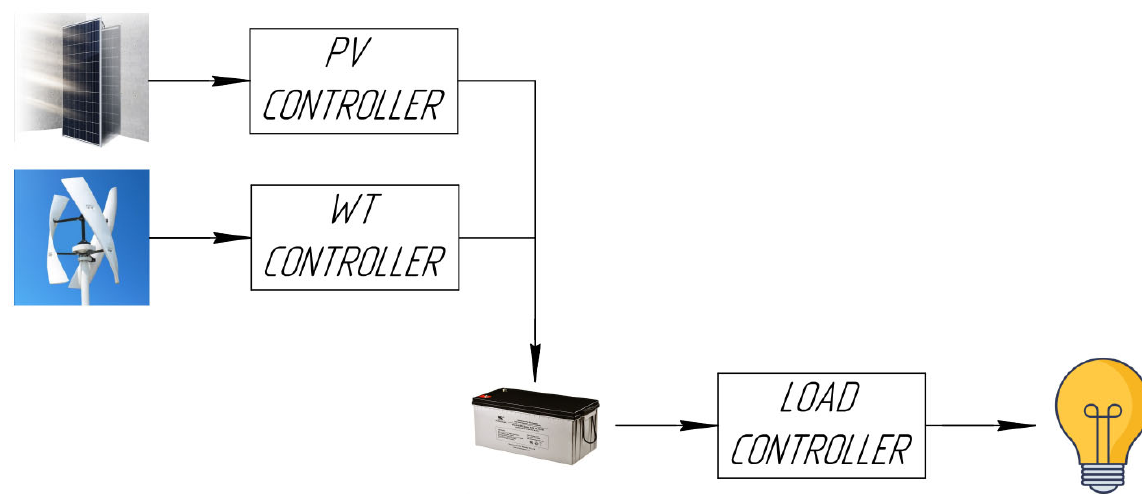
Figure 1. Scheme of power supply system.